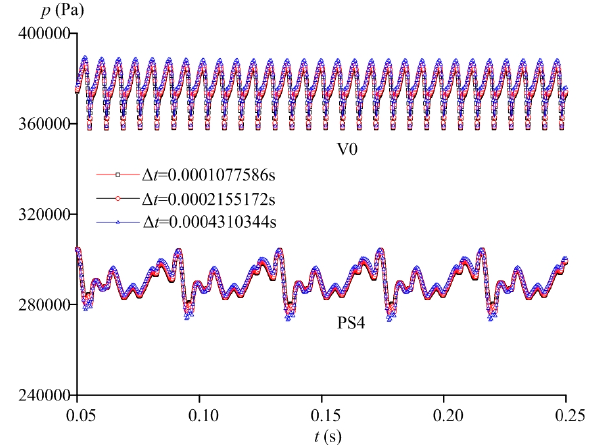
Figure 3 . Time histories of pressure fluctuations on PS4 and V0. Figure 3. Time histories of pressure fluctuations on PS4 and